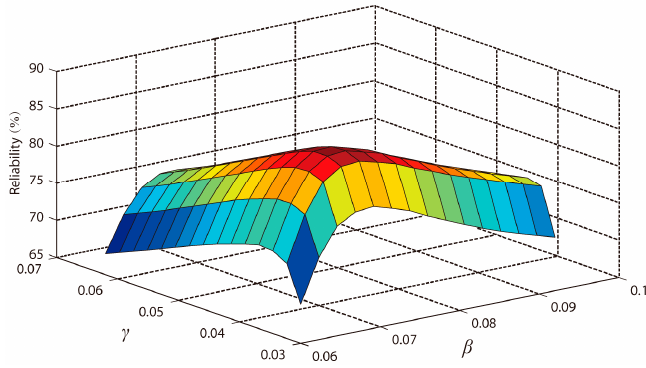
Figure 3. The reliabilities of the proposed STTTA in various values of β and γ .